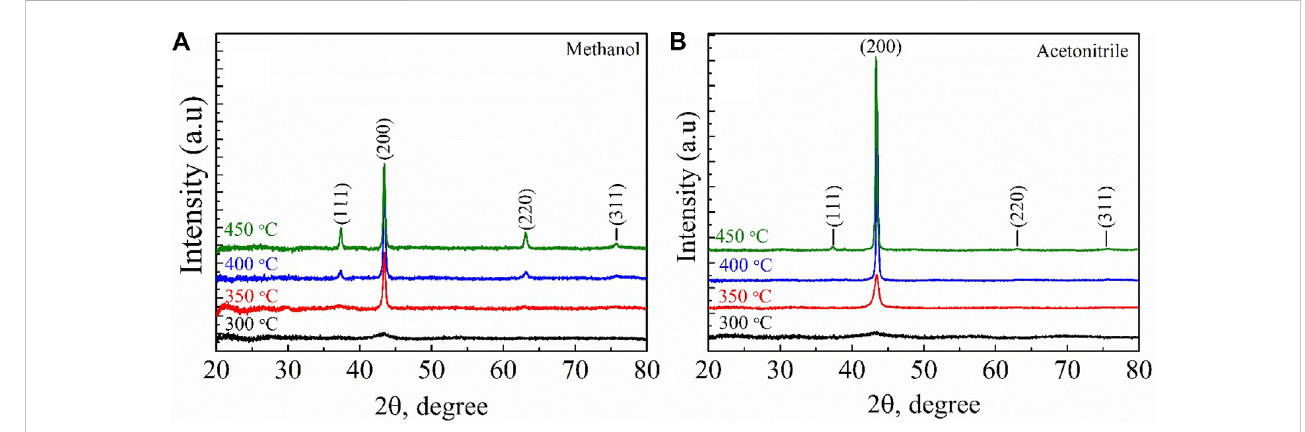
X-ray diffraction patterns of NiO x thin fi lms obtained from (A) methanol, and (B) acetonitrile as solvent. The deposition temperatures for NiO x are 300, 350, 400, and 450 ° C, respectively.